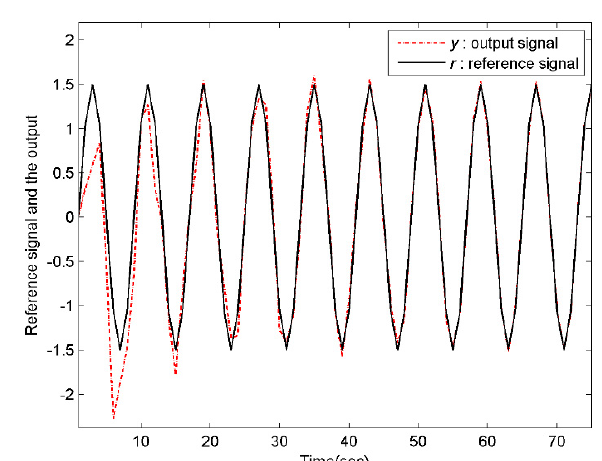
Figure 2. Tracking curve under h r = 30, h d = 6.